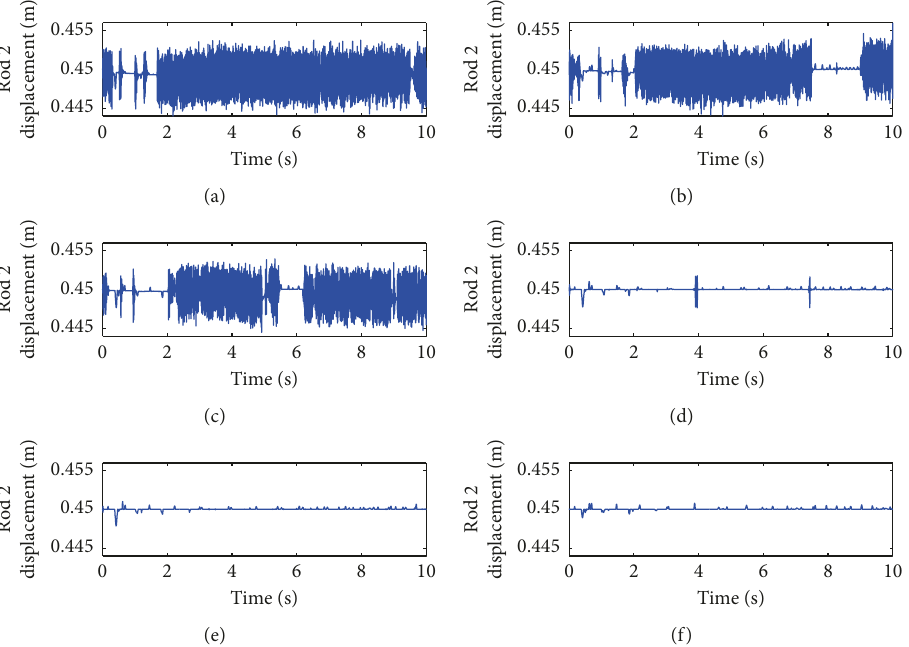
Figure 17: Displacement x 2 of rod 2 with different damping coefficients D with c (c) D � 3kN; (d) D � 4 kN; (e) D � 5kN; (f) D � 6kN.